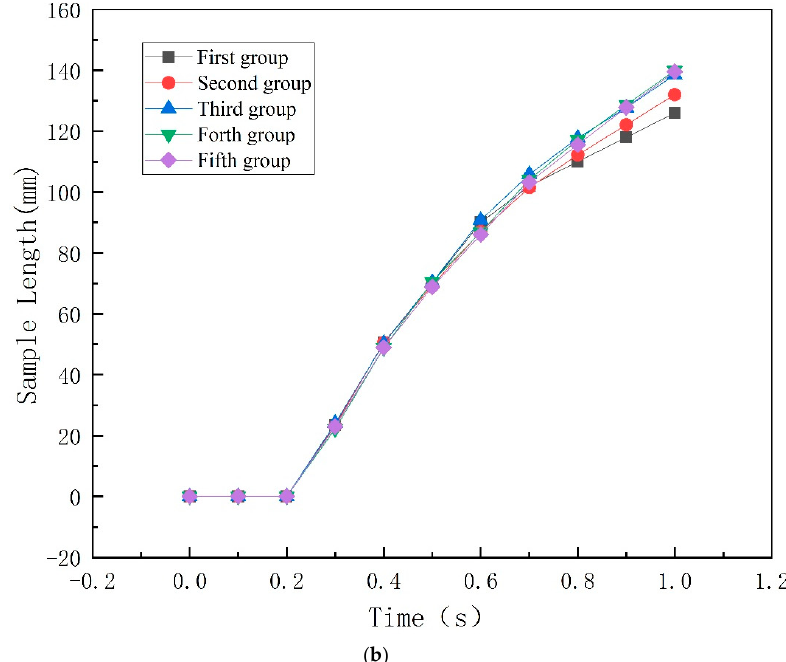
Figure 5. ( a ) The simulation results at mesh test; ( b ) The sampling length under different mesh numbers.